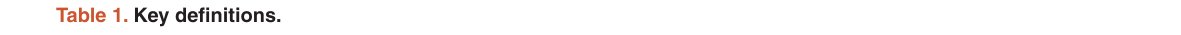
Table 1. Key definitions. Effector phase: Time period between the initial infection and when the accumulation of effector cells has